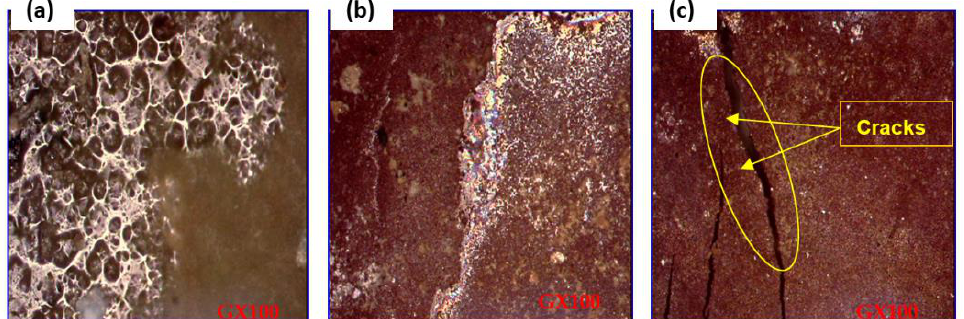
Figure 9. Metallographic observation of coated samples (cathodic loading) in the GX100 salt fog chamber of the coated steel in the different soil extracts, ( a ) clay, ( b ) soil, and ( c ) sand.